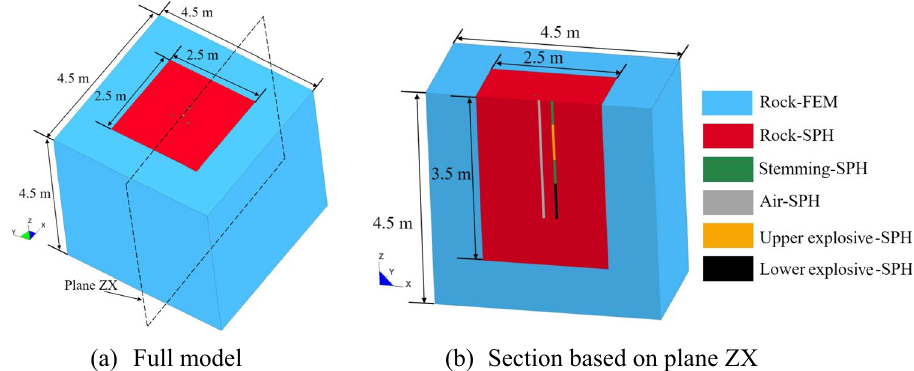
(b) Section based on plane